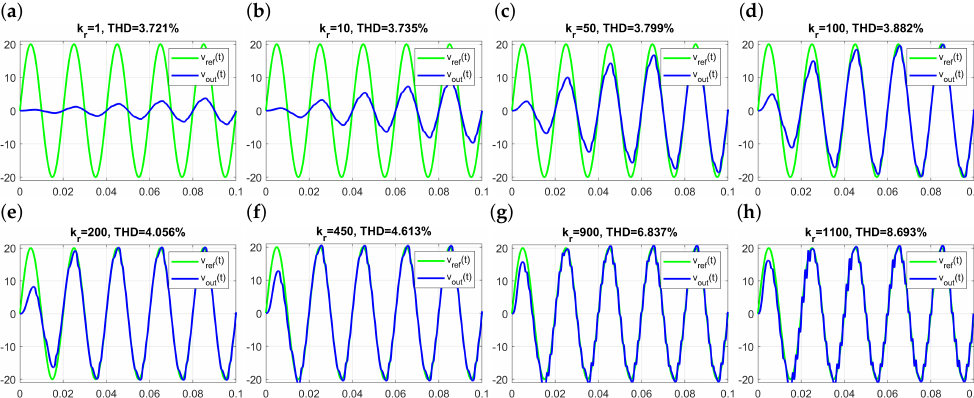
Figure 33. Start-up process of the R control. ( a – h ) Transients of v out ( t ) ordered for increasing values of k r . Note that it is slower than in OL in Figure 29, even for large k r